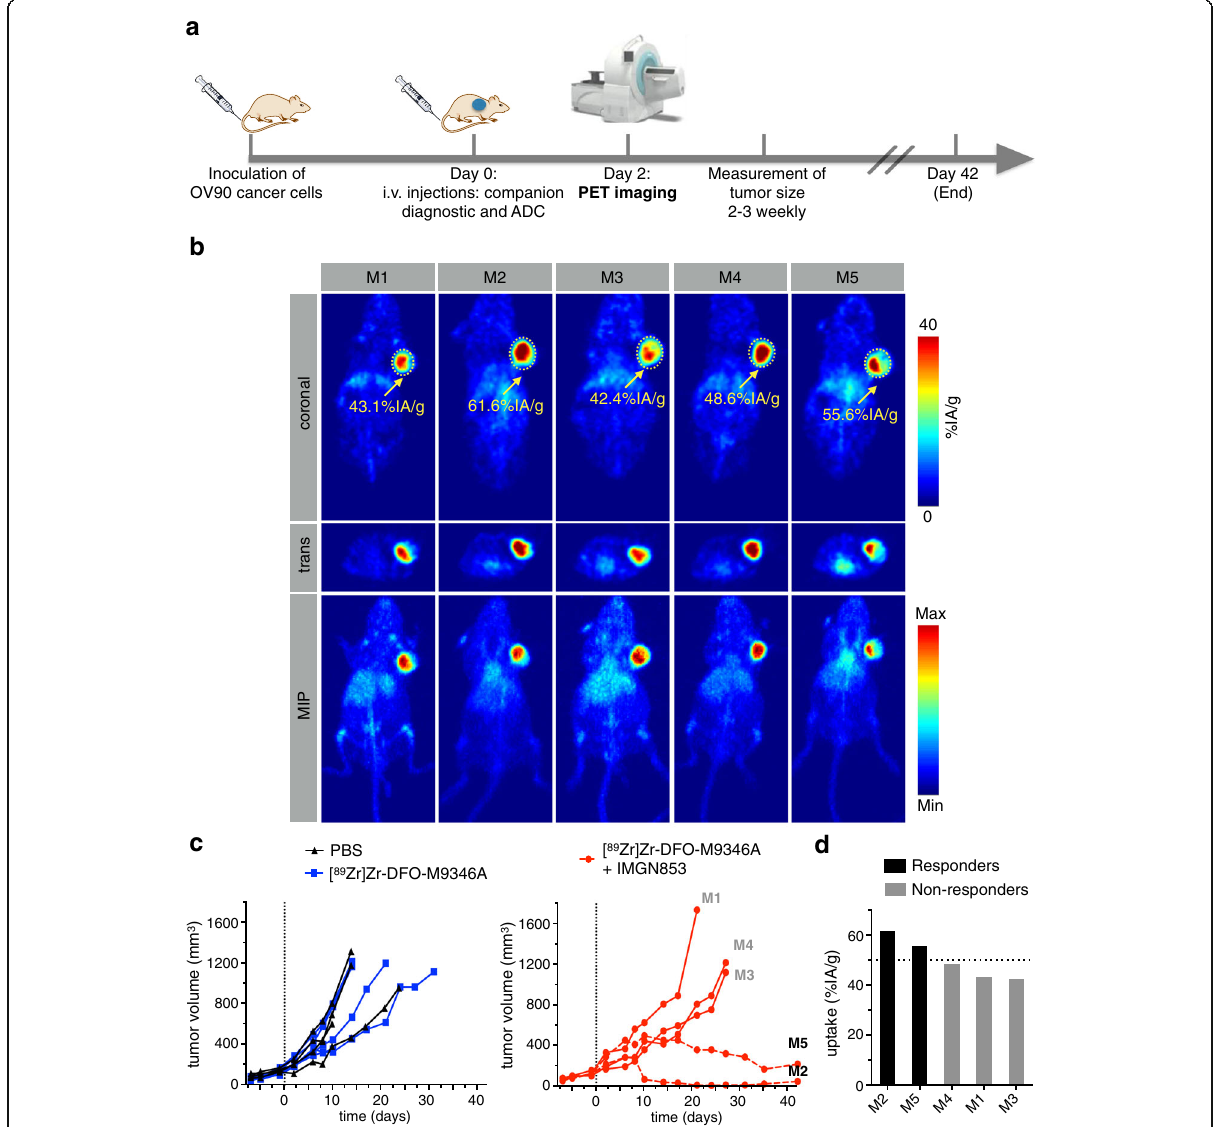
Fig. 5 Therapy study with antibody-drug-conjugate, IMGN853, and companion diagnostic, [ 89 Zr]Zr-DFO-M9346A, using OV90 xenografts. a Overall design of the therapy study including inoculation of cancer cells, injection of ADC and companion diagnostic, PET imaging after 2 days, and continuously measuring tumor growth. b PET images of mice injected with [ 89 Zr]Zr-DFO-M9346A (90.3 ± 1.1 μ Ci, 25 μ g) and IMGN853 (1.25 mg/ kg, 31.2 μ g) and quantification through ROI analysis of coronal slices. c Plot of the individual tumor volume post treatment (days). d Correlation of tracer uptake (%IA/g) and therapy